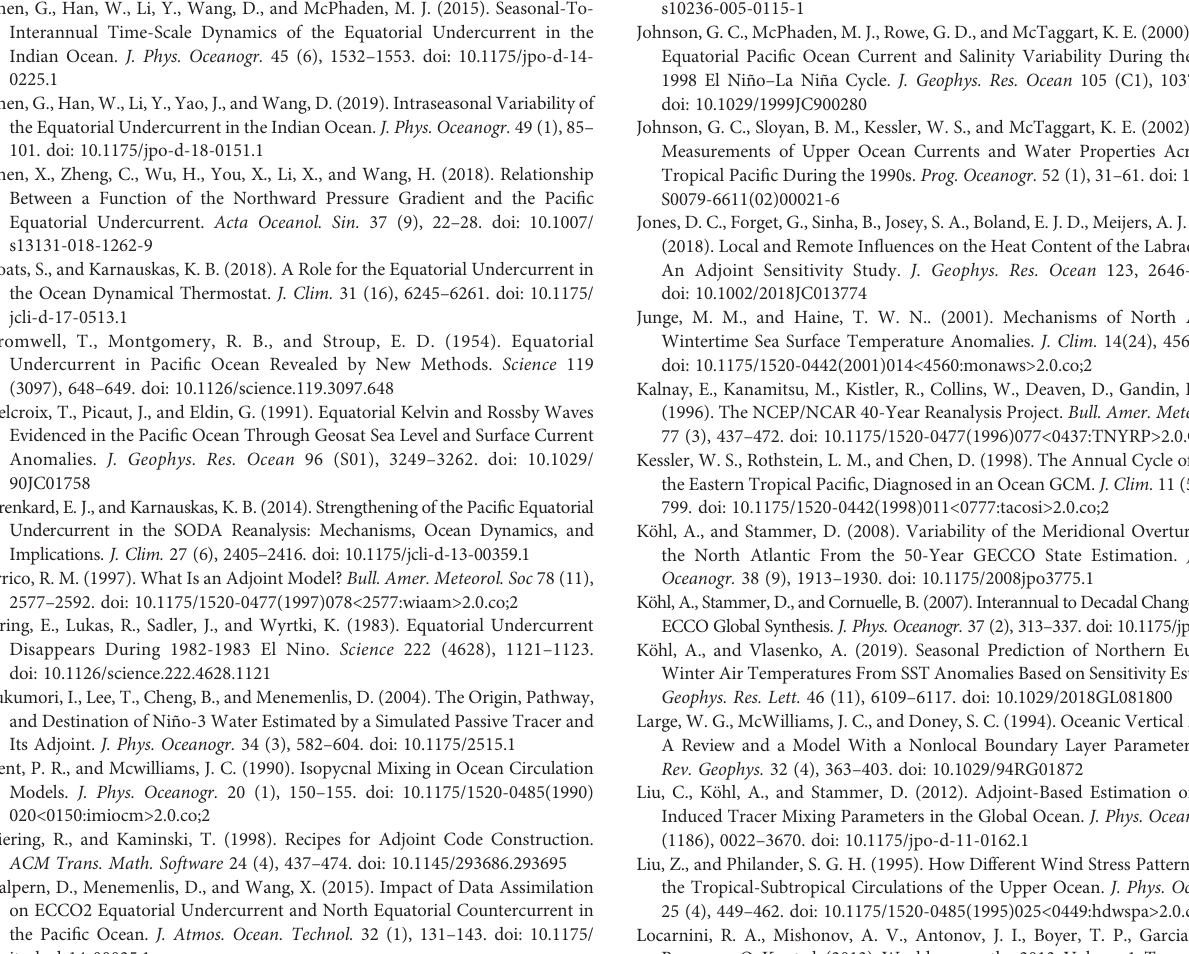
Supplementary Figure 3 | Responses of EUCT in July to the wind perturbations with various magnitudes at month – 6, via varying the wind perturbation ratio from -0.35 to 0.35 at an interval of 0.1.